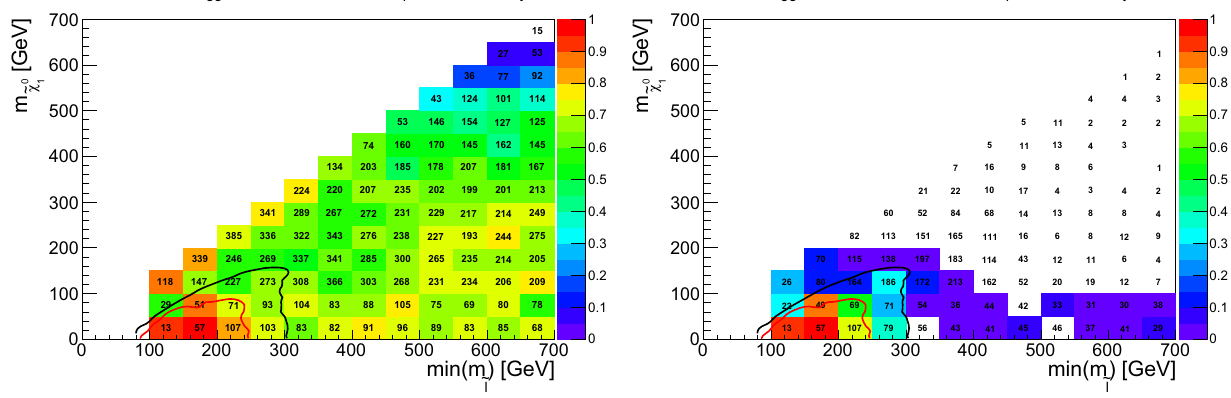
right only EW analyses. The color code indicates the fraction of points excluded by SModelS as compared to ATLAS, while the text gives the total number of points tested in each bin. The exclusion lines for ˜ l R (red) and ˜ l L (black) are also shown for comparison